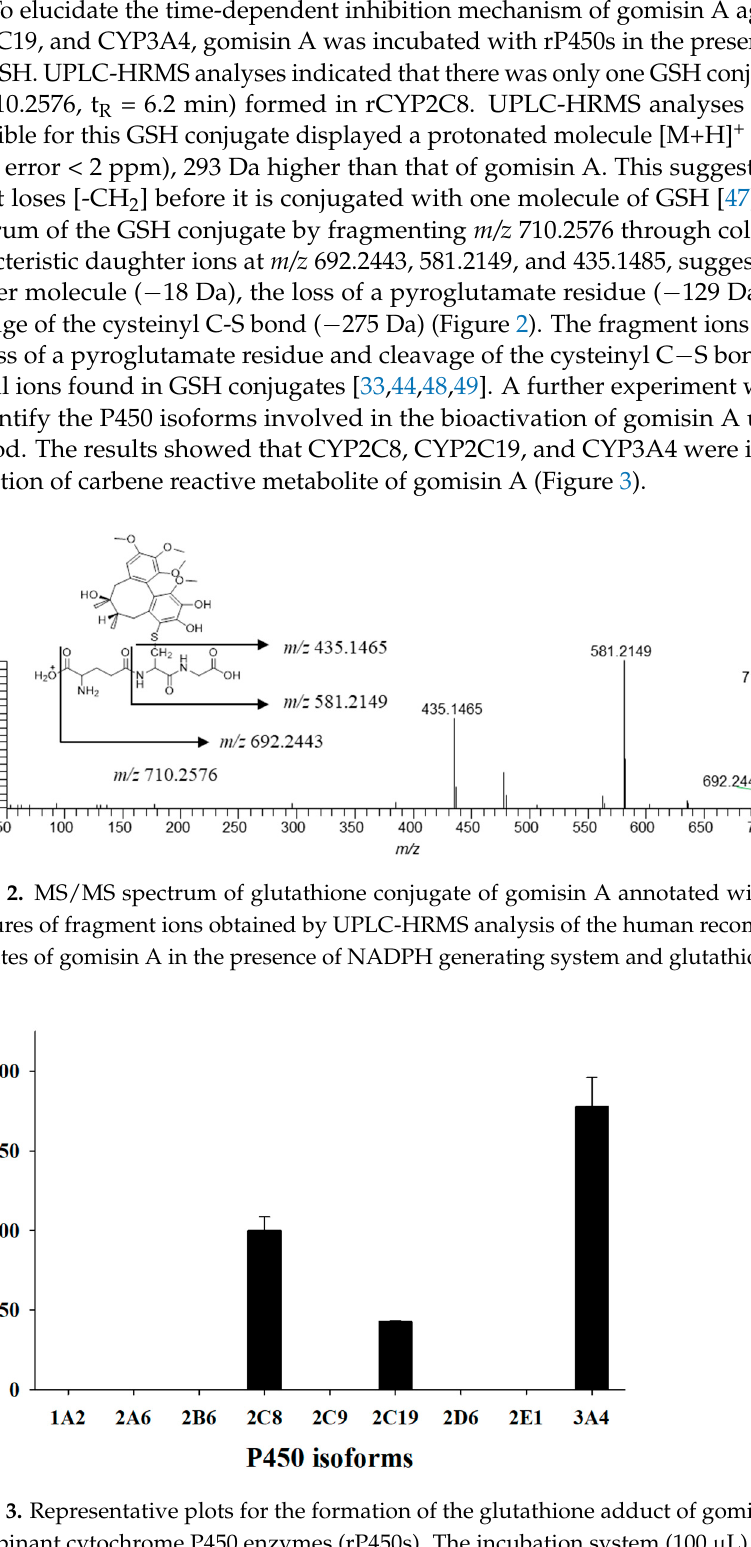
Figure 3. Representative plots for the formation of the glutathione adduct of gomisin A by human recombinant cytochrome P450 enzymes (rP450s). The incubation system (100 µ L) contained 0.1 M phosphate buffer solution (pH 7.4), 1 pmol P450 isoforms, 50 µ M gomisin A, 2 mM NADPH, and 5 mM glutathione. Each data represent the mean ± SD of triplicate determinations.